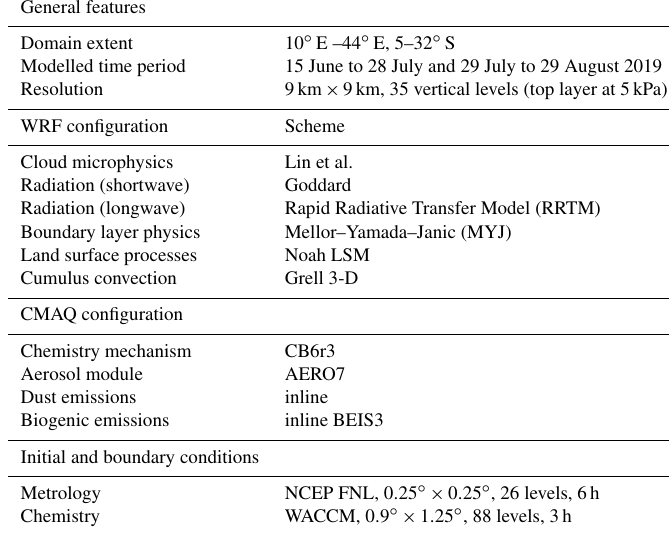
Table C1. Summary of WRF-CMAQ model